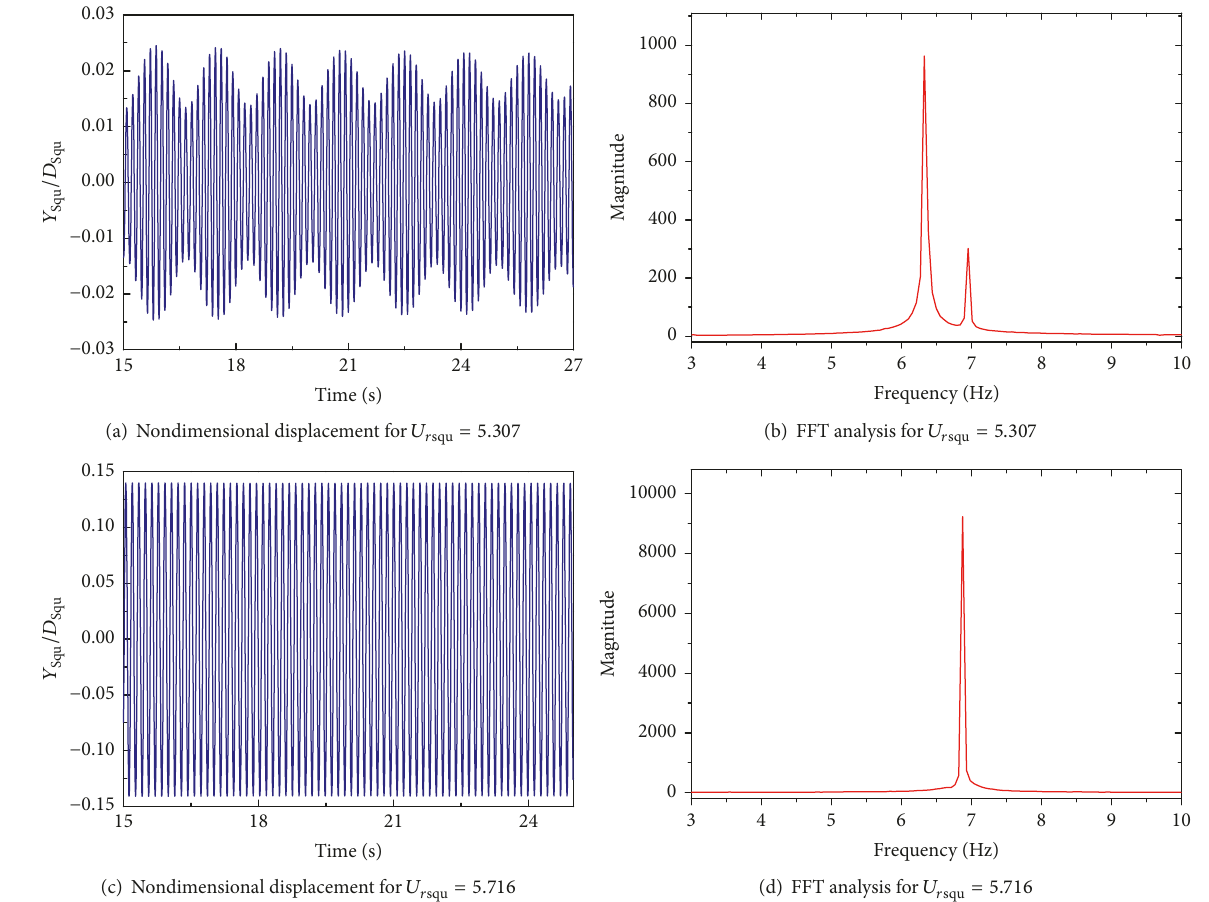
Figure 6: Displacement time-history and FFT analysis results for 𝛼 = 15 ∘